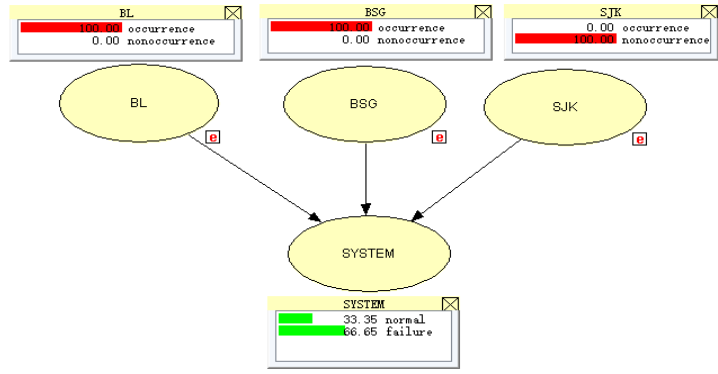
Figure 23. The cascade system failure probability of failure path 2.